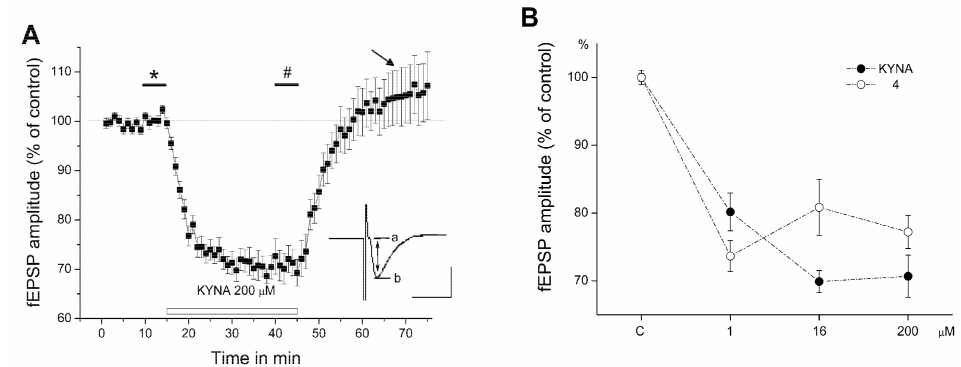
Figure 1. E ff ect of KYNA and 4 (one of its derivatives) on the field excitatory evoked potentials (fEPSPs) recorded in CA1 region of hippocampus. A : KYNA administration (in 200 µ M concentration) for 30 min resulted in decrease of the fEPSPs’ amplitudes reversibly. During wash-out, the amplitudes not only recovered but also were facilitated in the recorded period (arrow) *: samples for the baseline were taken during the last 5 min of control period. #: samples for calculation of the e ff ect were taken during the last 5 min of wash-in period. Inset: an original fEPSP. Amplitudes were measured from ‘a’ to ‘b’. Calibration: 20 ms and 0.5 mV. B : dose-dependent responses to KYNA and 4 in concentrations 1 µ M, 16 µ M, and 200 µ M, respectively. In case of KYNA, n = 7 at 1 µ M and 16 µ M and n = 10 at 200 µ M. In case of 4 n = 10 at 1 µ M and 16 µ M and n = 8 at 200 µ